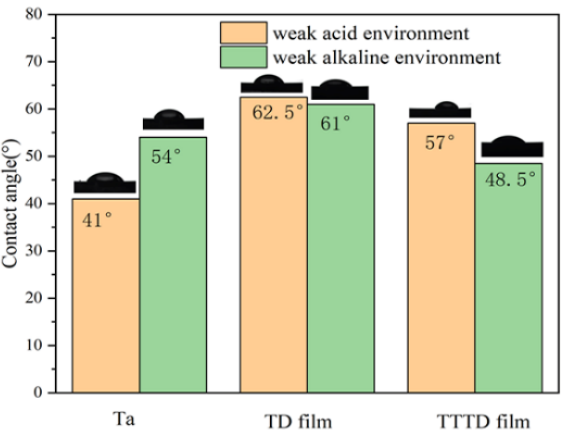
Figure 12. Contact angles of Ta substrate, TD and TTTD films in weak acid and weak base environ-